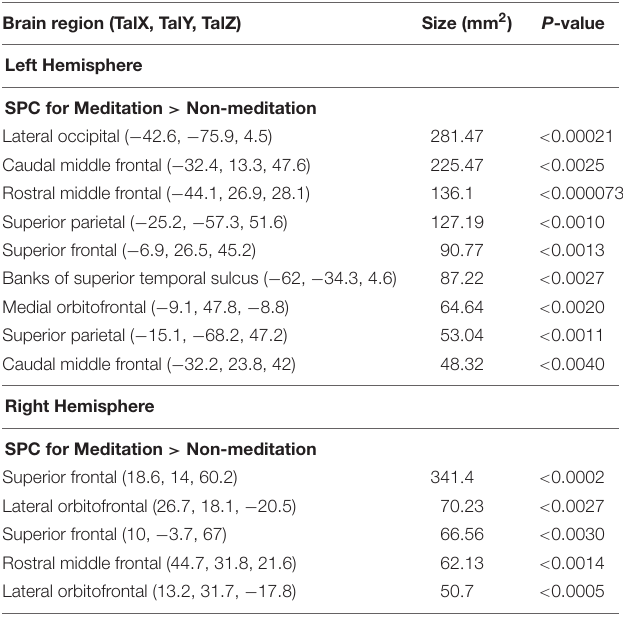
TABLE 6 | Brain regions showing significant gray matter volume SPC changes (increase/decrease) in voxel-based analysis between the meditation and non-meditation groups corrected for multiple comparisons, age, gender, and education in both hemispheres. Brain region (TalX, TalY, TalZ) Size (mm 2 ) P